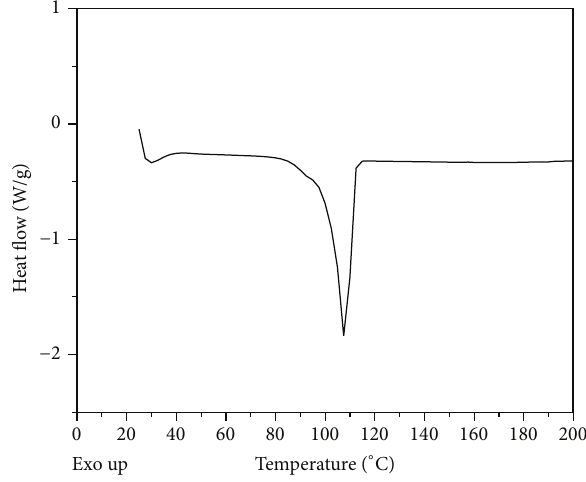
Figure 2: DSC thermogram of